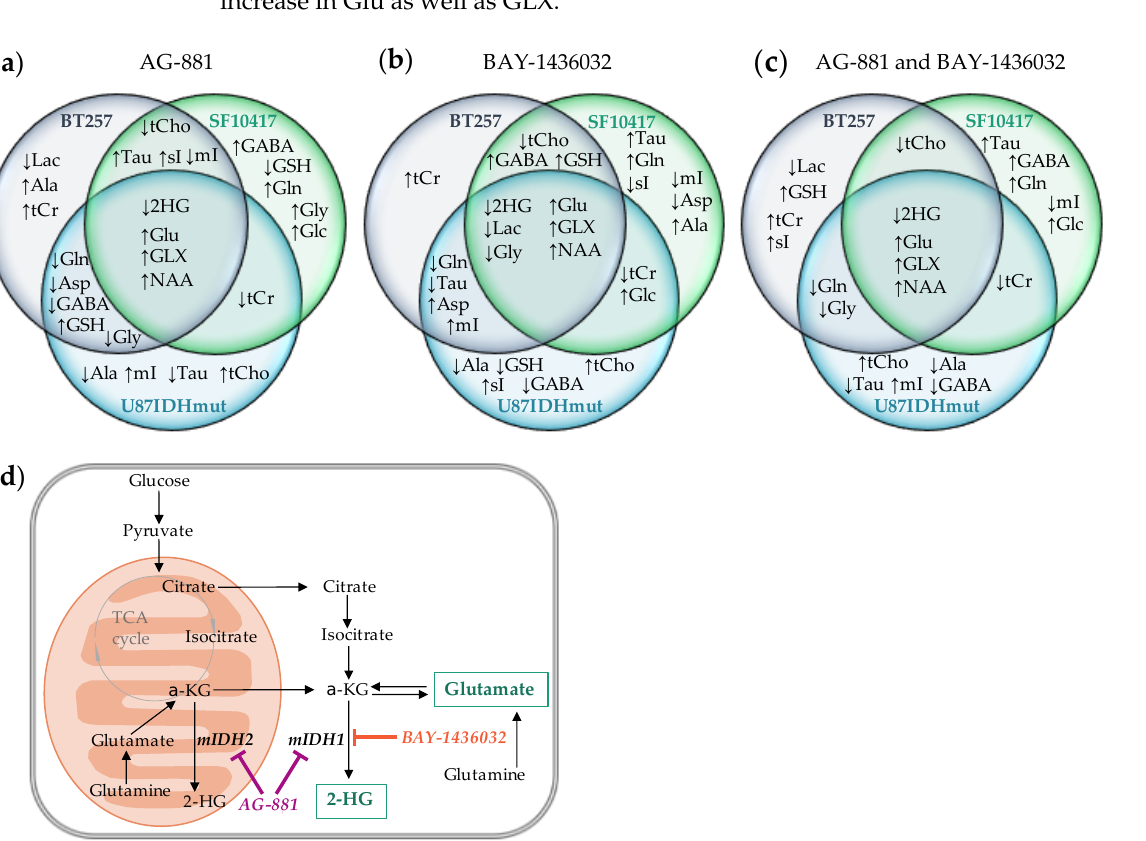
Figure 5. Diagrams of metabolic alterations occurring in U87IDHmut, BT257 and SF10417 models at early time points (D5 ± 1 for U87IDHmut model (blue), D7 ± 2 for BT257 model (grey) and D6 ± 2 for SF10417 model (green)) prior to MR-detectable differences in tumor volume, following treatment with mutant IDH inhibitors AG-881 ( a ) or BAY-1436032 ( b ). Diagram showing changes that occur in each model with both treatments and highlighting the metabolic changes that occur for all models with both treatments (intersection of all three circles at center) ( c ). Metabolic pathways illustrating the MR-detectable metabolites altered following mutant IDH1/2 inhibition ( d ).